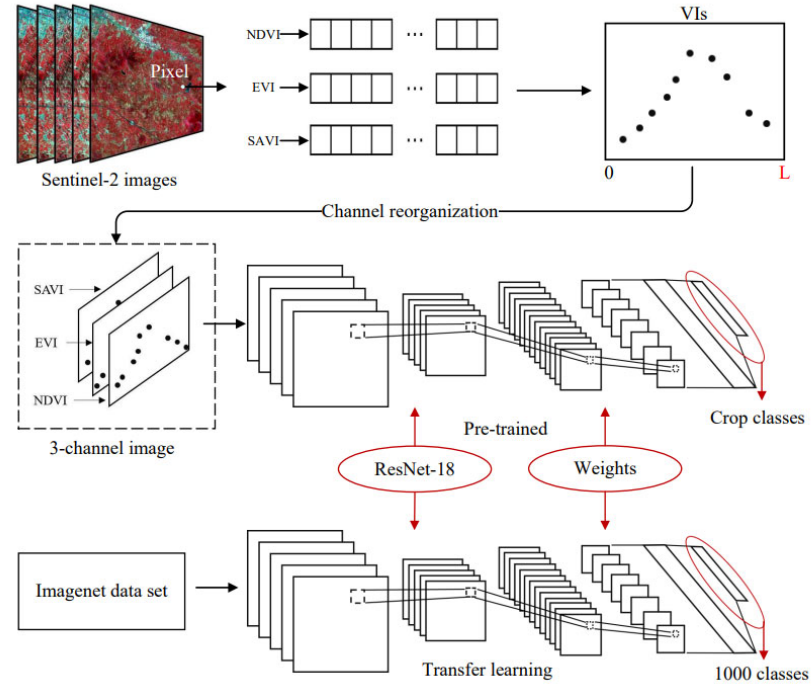
Figure 7. Classification flow chart based on 2DCNN.